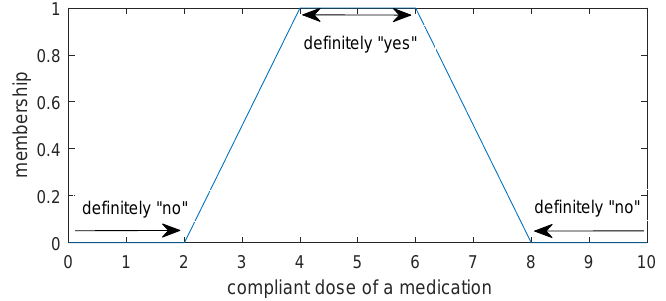
Figure 2. Membership of a fuzzy set defining compliant dose of a medication.